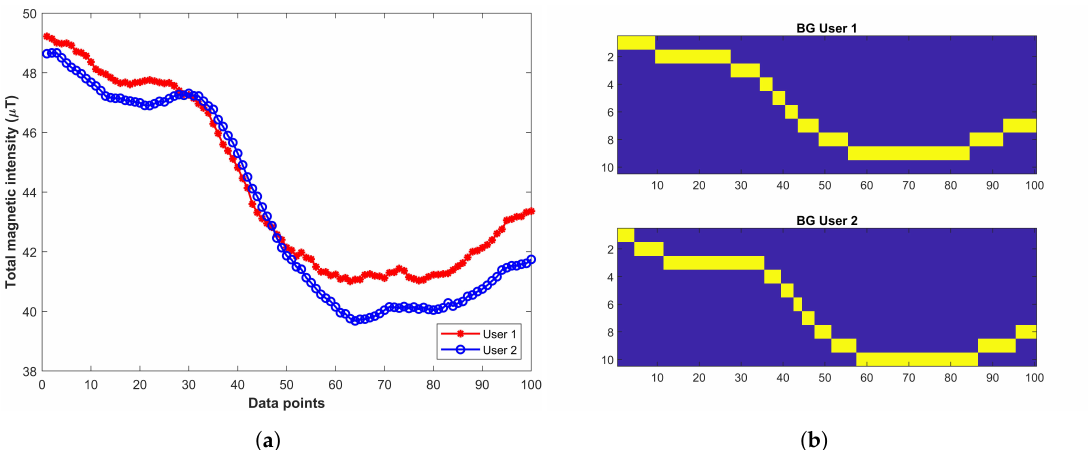
Figure 5. Magnetic data and its associated binary grid, ( a ) Data with same smartphone from different users, ( b ) Binary grid of magnetic data in Figure